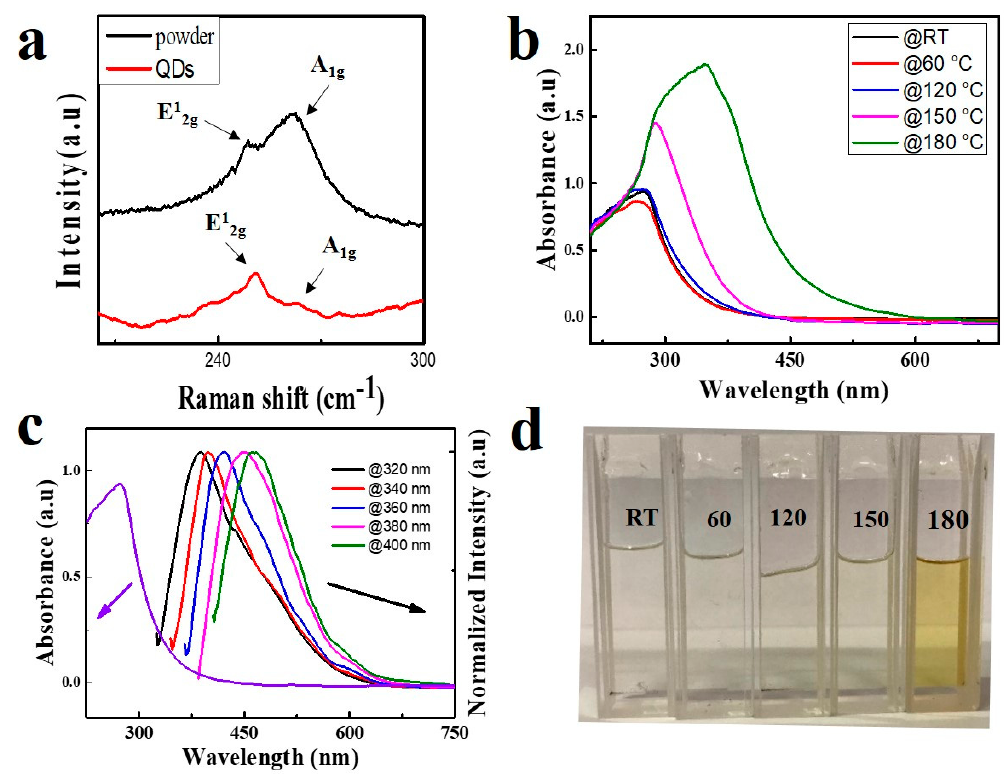
Figure 2. ( a ) Raman spectra of WSe 2 quantum dots (QDs) ( b ) Ultraviolet-visible absorption spectrum of WSe 2 QDs at different thermal treatment temperatures for 16 h. ( c ) Ultraviolet-visible light absorption spectra of WSe 2 QDs and photoluminescence (PL) spectra of WSe 2 QDs at different excitation wavelengths. ( d ) Photographs of the WSe 2 QDs solution with different thermal treatment temperatures.